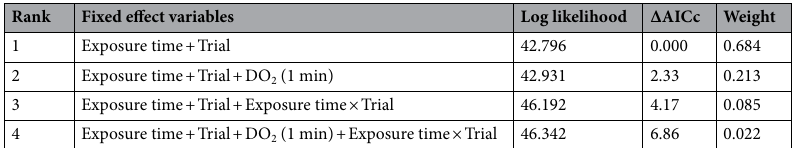
Table 4. Ranking of candidate generalized linear mixed models (beta error structures with logit link) to explain the vitality of Atlantic mackerel ( Scomber scombrus ) during sea cage crowding trials. The “DO 2 (1 min)” term indicates a moving average of dissolved oxygen conditions in the cage 1 min prior to vitality sampling. AICc refers to Akaike Information Criteria (corrected for small sample size) and “Weight” to normalised Akaike